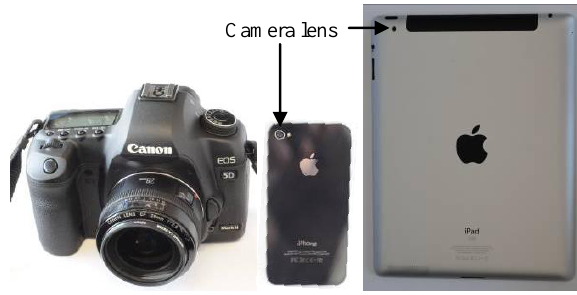
Figure 1. Images of the Canon EOS 5D Mk II, iPhone 4G and iPad 2 (left to right respectively)